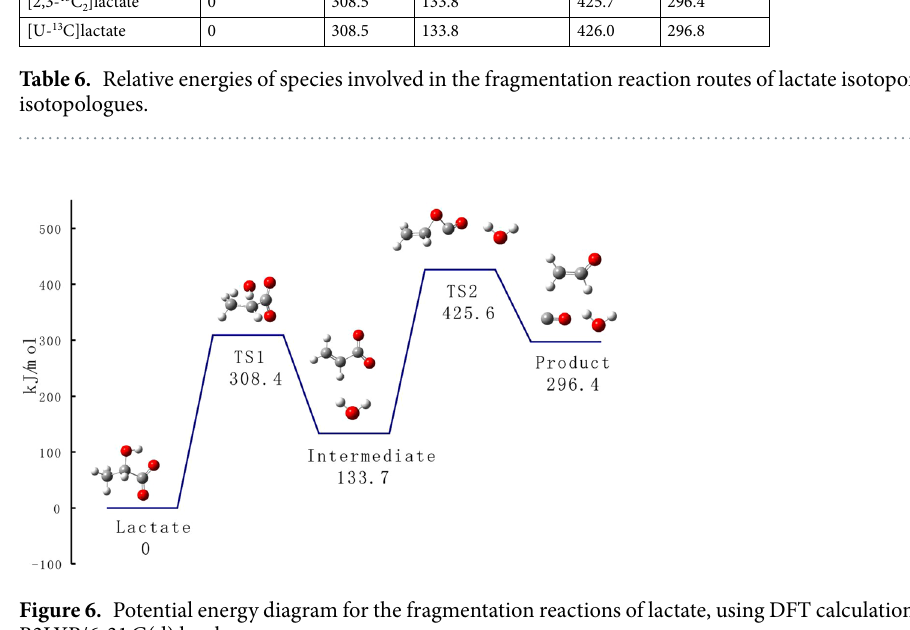
their concentration ratio, respectively, indicating that 13 C-labelling of lactate at different positions differentially influences its fragmentation efficiency under tandem mass spectrometry condition. The lactate and [2,3- 13 C 2 ]lactate (or [1- 13 C]-, [3- 13 C]-, [U- 13 C]lactate) mixed standard solutions mentioned above were analyzed by LC-MS under Q1 multiple ions mode, in order to investigate whether 13 C affects ion- ization process of 13 C-labeled lactate. Data in Supplementary Tables S11–S14 point out that 13 C slightly affect ionization of 13 C-labeled lactate under MS condition.